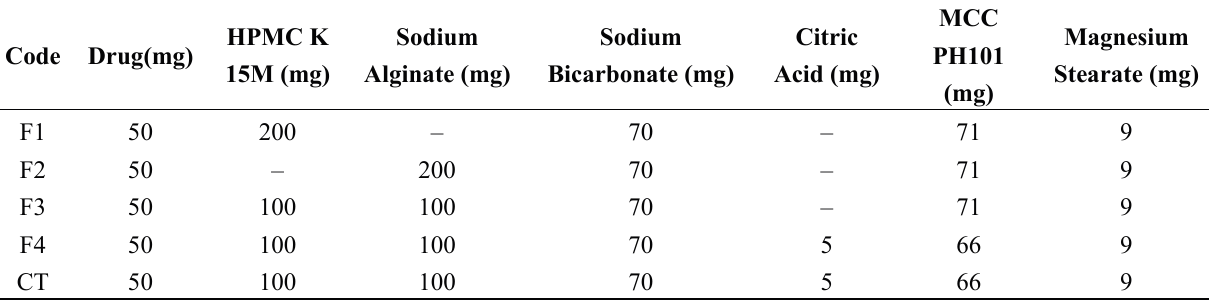
Table 1. Formulation design of gastroretentive floating tablets of MSC CMN (F1–F4) and CMN